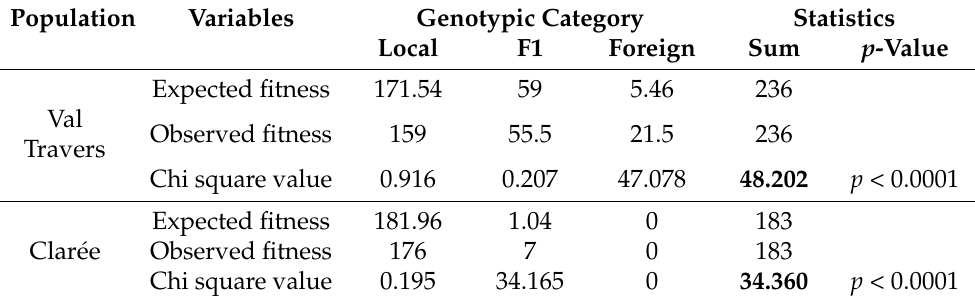
Table 2. Goodness-of-fit Tests on the observed fitness (estimate of the number of offspring sired) for the C1 genotypic categories (local, F1, foreign) in Val Travers and Clar é e